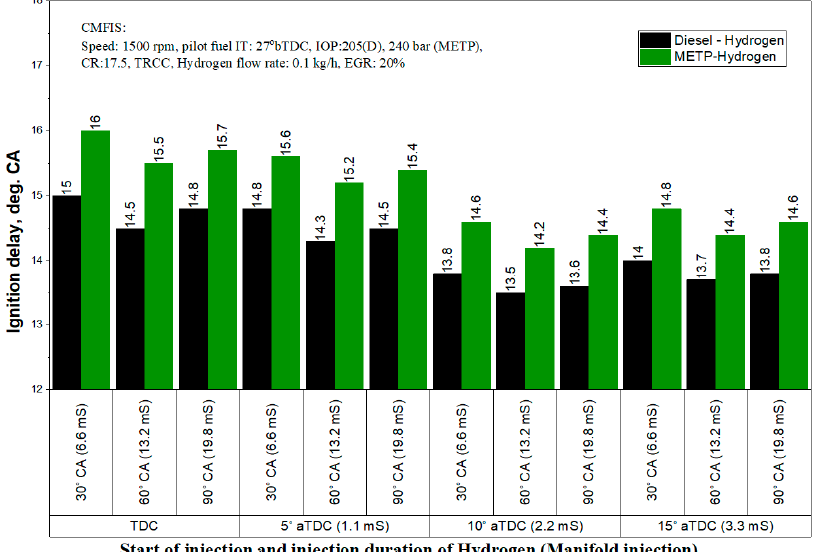
Figure 15. Ignition delay for manifold injection of hydrogen in CMFIS based dual-fuel engine.